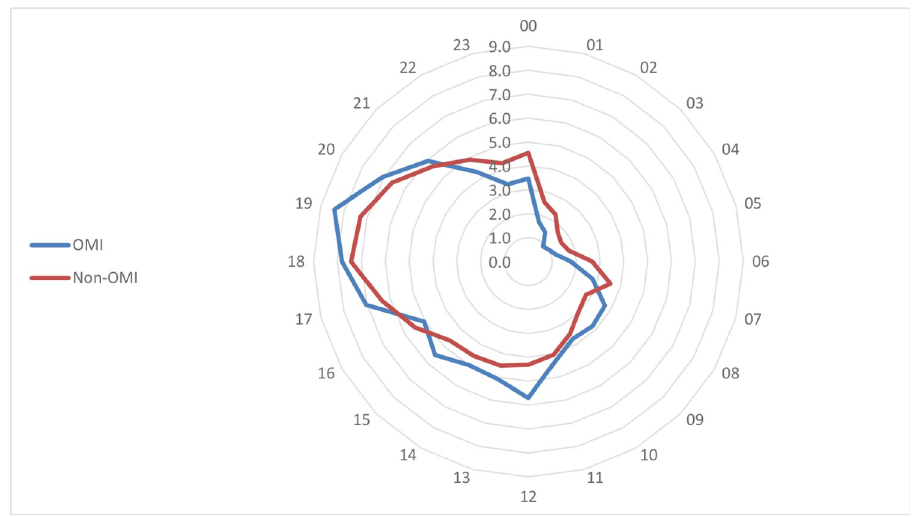
Fig 4. Comparison of OMI and non-OMI according to injury time. OMI; occupational motorcycle injury.